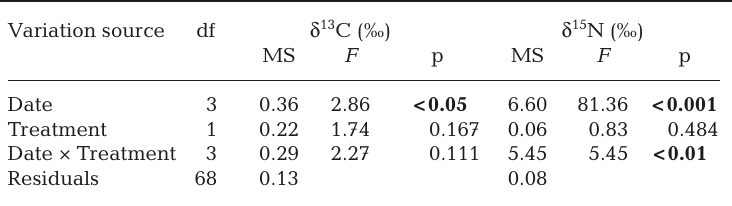
Variation source